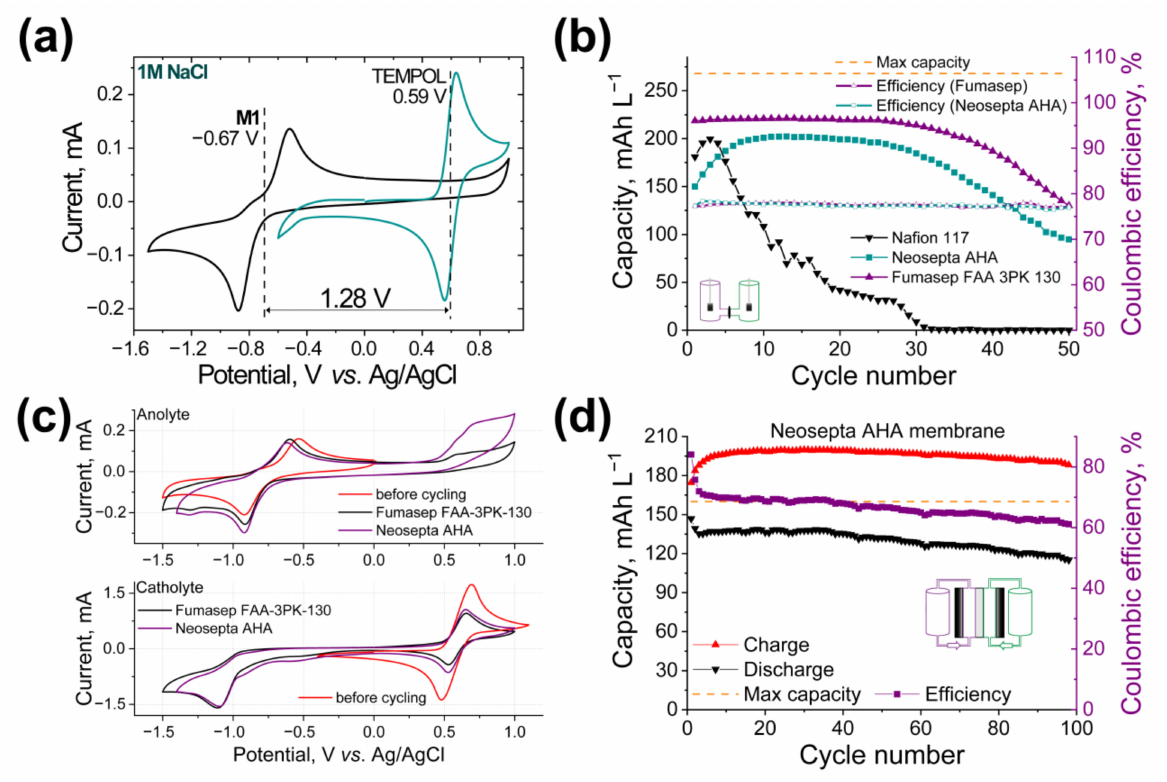
Figure 4. ( a ) CVs of M1 and TEMPOL. ( b ) Discharge capacities vs. cycle number and Coulombic efficiencies of the h-cell based on 5 mM M1 and 10 mM TEMPOL with Nafion 117, Fumasep FAA-3PK- 130, and Neosepta AHA membranes. ( c ) CV of the anolytes and catholytes before and after cycling of the h-cells with Fumasep-3PK-130 and Neosepta AHA membranes. ( d ) Electrochemical performance of the RFB with 3 mM M1 anolyte and 30 mM TEMPOL catholyte in 1.0 M NaCl water solution during 100 cycles. Cyclic Coulombic efficiency, charge, and discharge capacity as the functions of a number of cycles are presented. Battery charging and discharging time was limited to 8000 s, that is, 138% of the theoretical battery